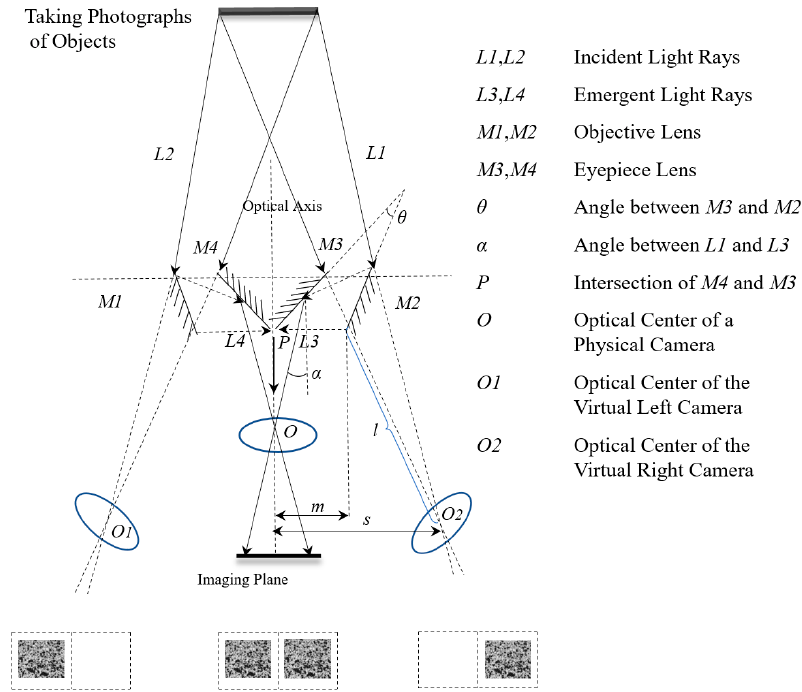
Figure 1. Structure drawing of DIC system with auxiliary device of four flat